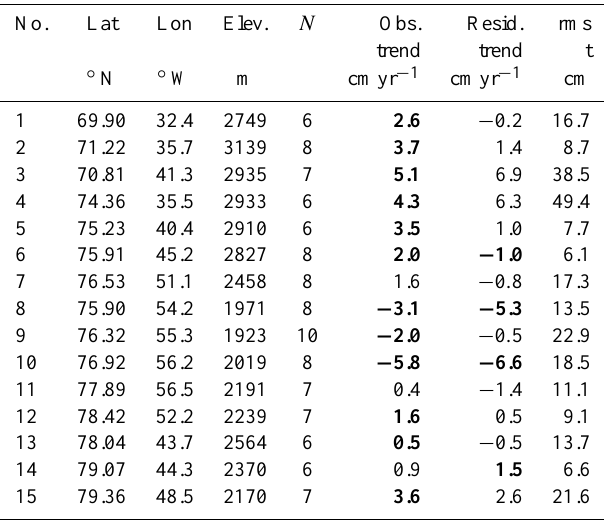
Table 1. Coordinates of analysed elevation change points labelled in Fig. 5 with the number of repeat observations N , observed sur- face elevation trend from the laser altimetry, the best-fit trend in the residuals between the observations and the firn model heights, and the root mean square of the residuals between the observations and fitted model (in cm). Trends in bold are significantly different than zero at 95%